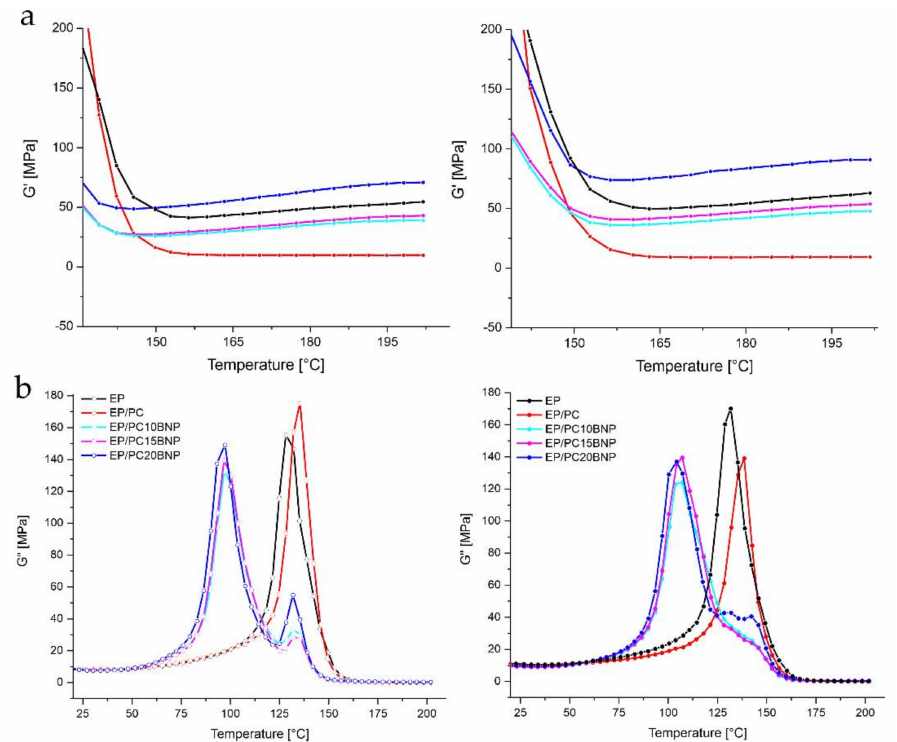
Figure A8. ( a ) Rubbery plateau of the storage modulus G (cid:48) . Left corresponds to the first heating run and, on the right, the second heating run; ( b ) Loss Modulus G (cid:48)(cid:48) of the composites. Left corresponds to the first heating run and, on the right, the second heating